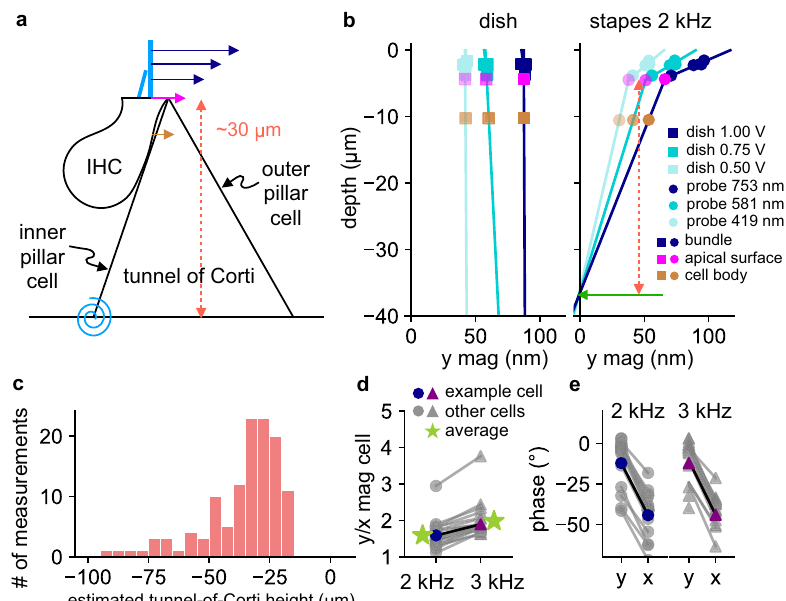
Fig. 6 Pivoting motion of the tunnel of Corti and the coupling of longitudinal- and radial-direction motions in the OoC. a An IHC is drawn in relation to the triangular tunnel of Corti in a radial cross section. The motion of the IHC cell body is indicated by a brown arrow, the stereocilium motions at different depths by blue arrows, and the calculated apical-surface motion by a magenta arrow. The hypothesized point of rotation of the tunnel of Corti is indicated by the blue rotational spring at the foot of the inner pillar cell. The vertical distance between the apical surface and the base of the tunnel of Corti (the height of the tunnel of Corti) is indicated by the vertical dashed line. b The measurement depth is plotted against the raw motion magnitude in the radial direction for the bundle (blue), apical surface (magenta), and cell body (brown), for three different stimulation levels, with dish stimulation shown on the left and 2-kHz stapes stimulation shown on the right. The extrapolated depth of the base of the tunnel of Corti for stapes stimulation is indicated by the green arrow, with the estimated tunnel-of-Corti height indicated by the vertical dashed line. c The extrapolated depths of the base of the tunnel of Corti (the estimated tunnel-of-Corti height) are plotted as a histogram for all stapes-stimulation runs. d For all cells, the cell-body motion magnitude in the radial ( y ) direction, normalized by the corresponding longitudinal ( x ) cell-body motion magnitude, is compared between the 2- and 3-kHz stapes stimulations ( p < 0.001). The green stars represent the average value of each group. e Phase comparisons between the radial ( y ) and longitudinal ( x ) motions are shown for all cells, for 2 kHz on the left and 3 kHz on the right ( p < 0.001 for both